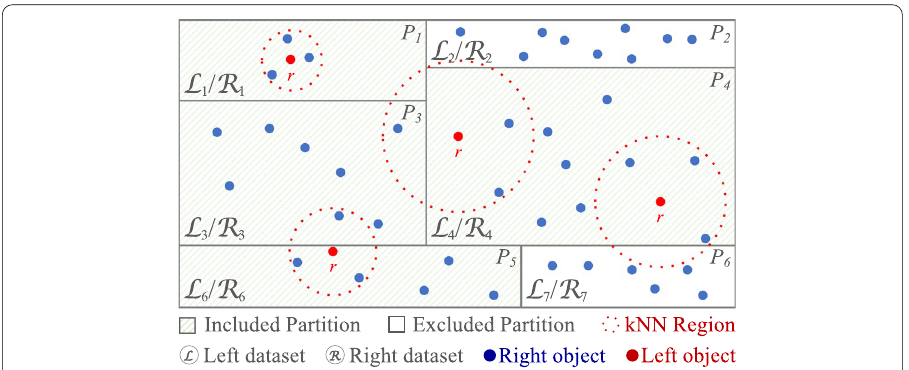
Fig. 2 Illustration of a spatial k NN join query between two